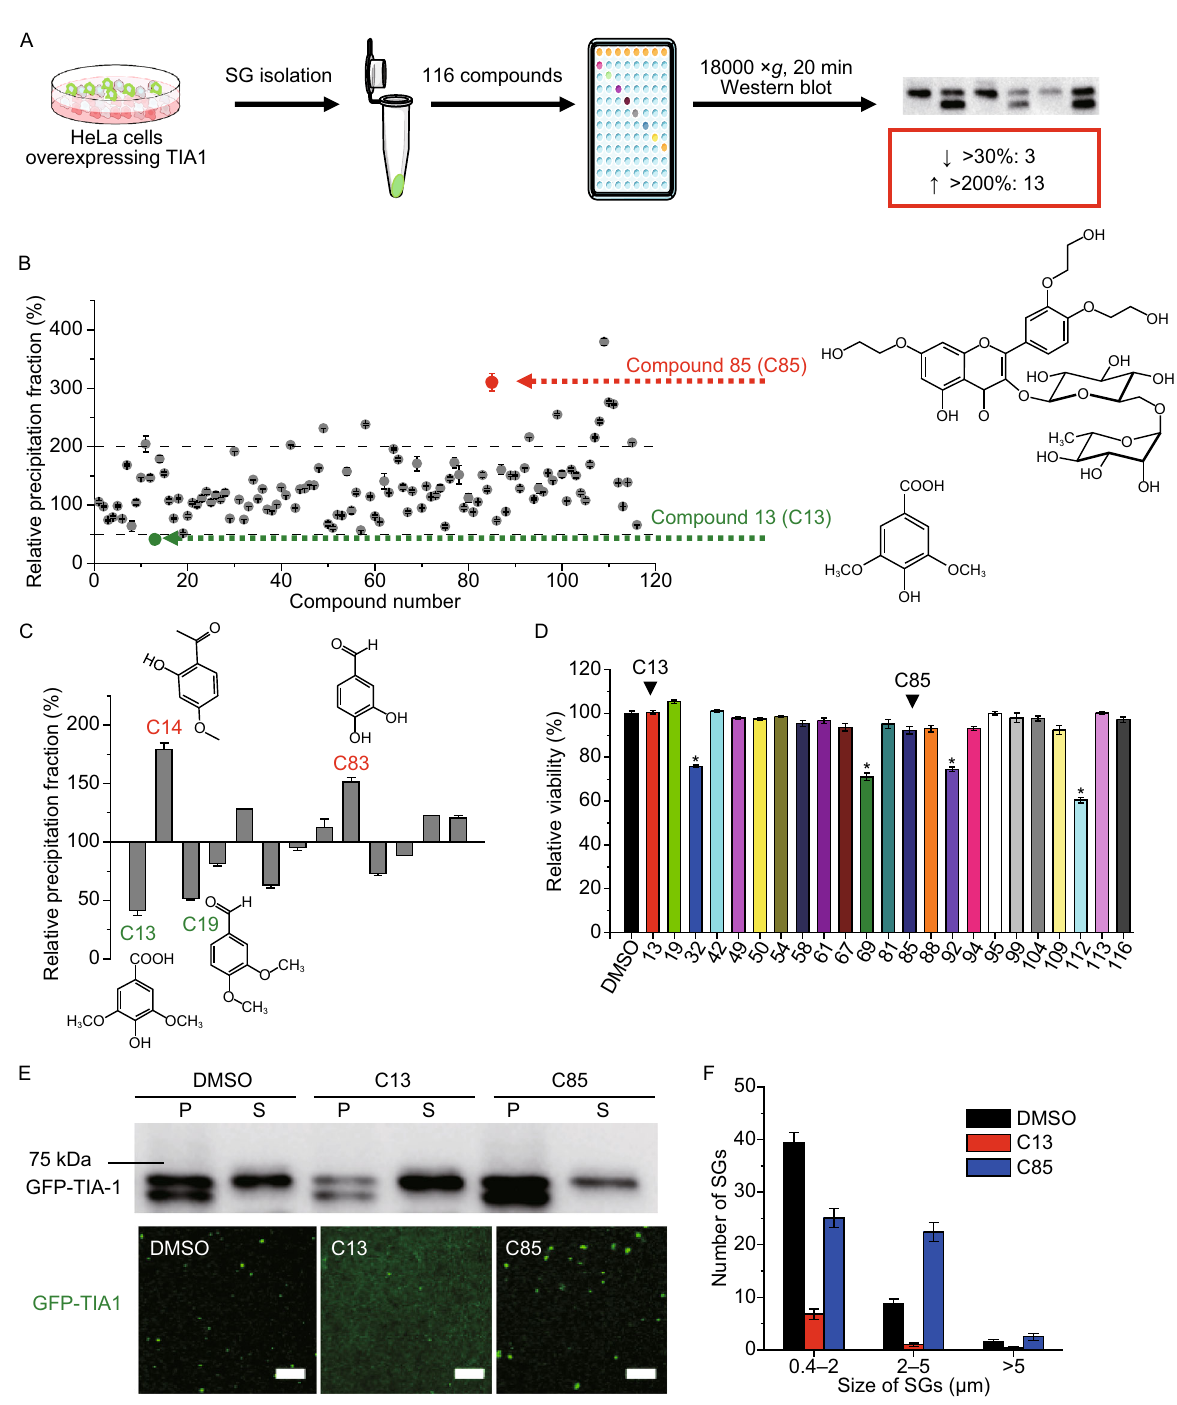
not affect the formation of protein aggregates formed by a disease-causing mutant α B-crystallin R120G visualized by the fused GFP or P bodies detected by a marker protein EDC4 (Fig. S1) or DCP1a (data not shown). This suggested that C13 and C85 were more likely to be speci fi c modulators of SG formation but not the other types of cytoplasmic